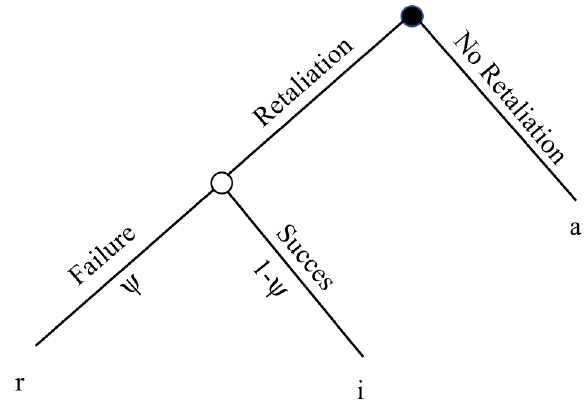
Figure 5. Retaliate or not? Choosing between two negative prospects. Source: author’s own analy ‐ sis.